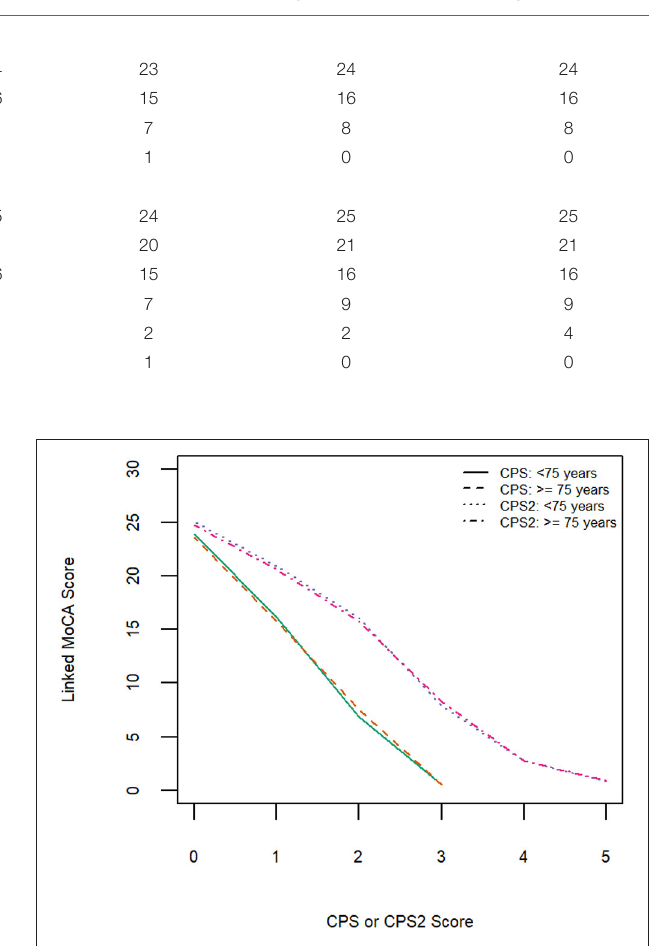
FIGURE 4 | Equipercentile linking function from CPS and CPS2 to MoCA-5min in two age groups ( < 75 years old and ≥ 75 years old).